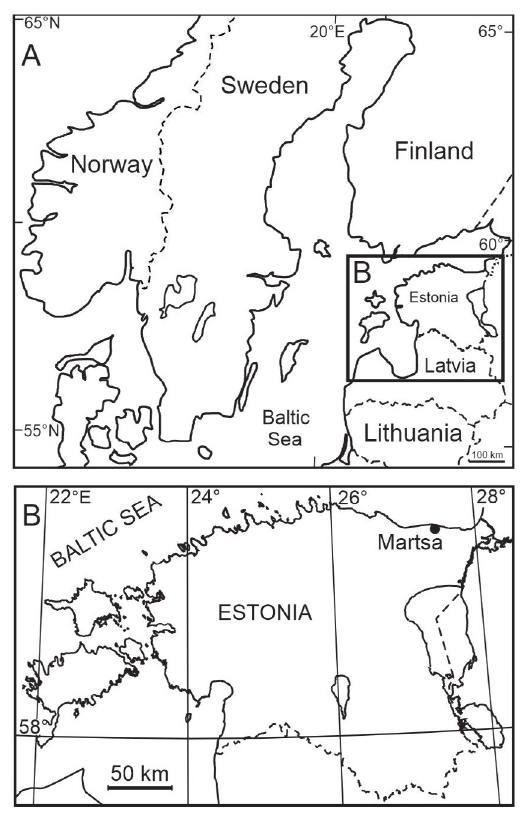
Fig. 1. Location of the study area ( A ) and Martsa quarry ( B ) in Northeast Estonia.